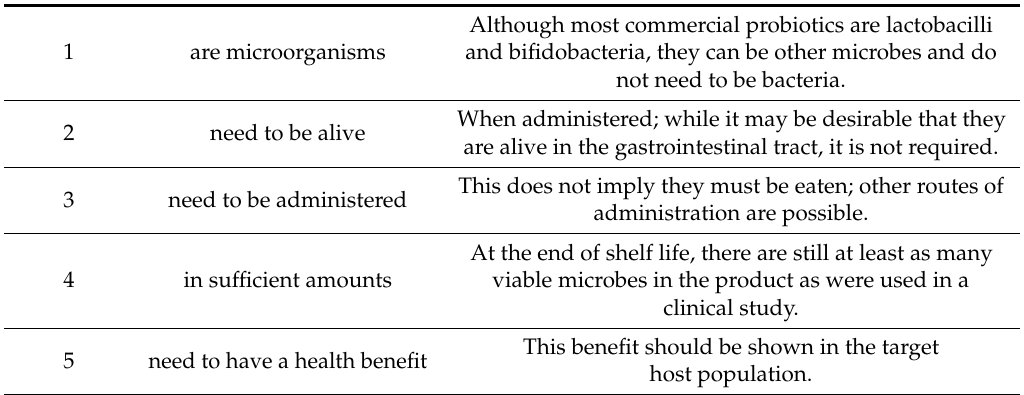
Table 1. Implications of the probiotic definition; set forth by Hill et al.